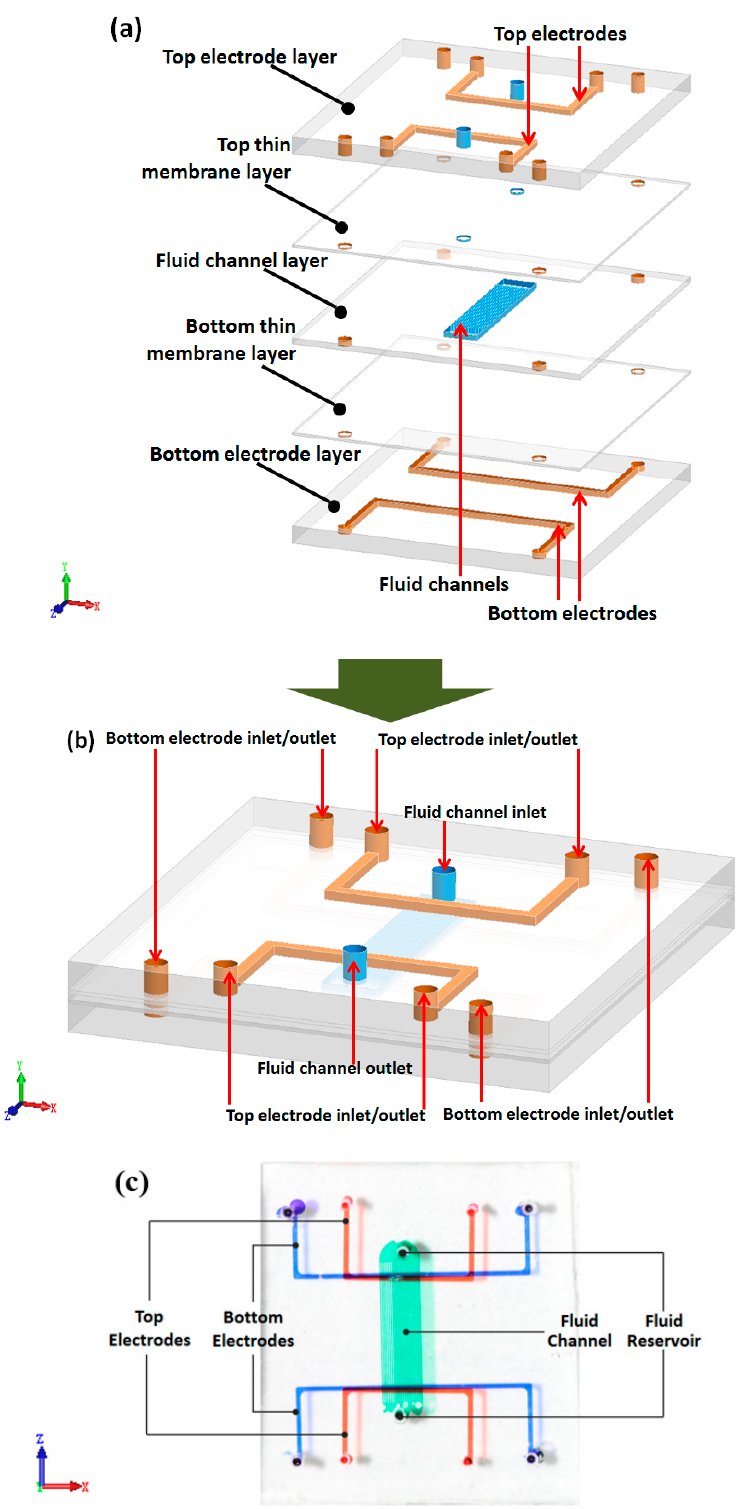
Figure 1. Schematic of the electroosmotic flow (EOF) pump. ( a ) Layer view; ( b ) combination view; ( c ) optical photograph of 3-demintional EOF pumps.